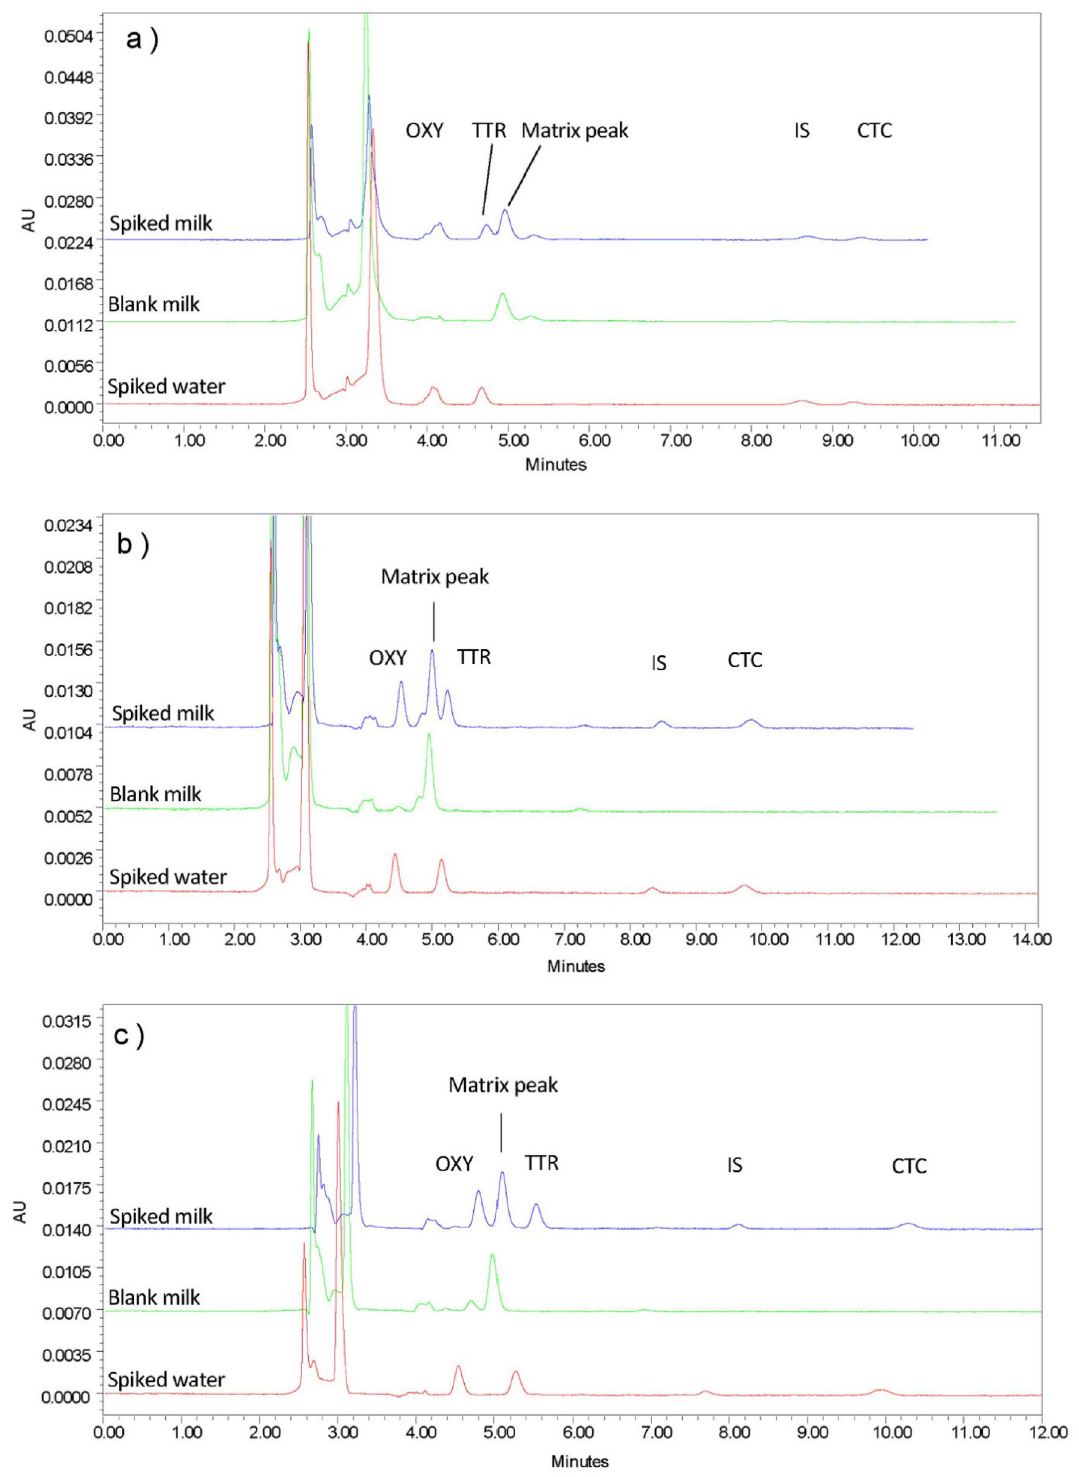
Figure 1. Effects of changing oxalic acid concentration on the drugs spiked cow milk. ( a ) 5 mM Oxalic acid:ACN:MeOH (70:20:10). ( b ) 10 mM Oxalic acid:ACN: MeOH (70:20:10). ( c ) 15 mM Oxalic acid:ACN:MeOH (70:20:10). Chromatographic conditions: Injection volume: 30 µL, Temperature: 25 ℃ , Flow rate: 1 mL/min, Detection wavelength: 358